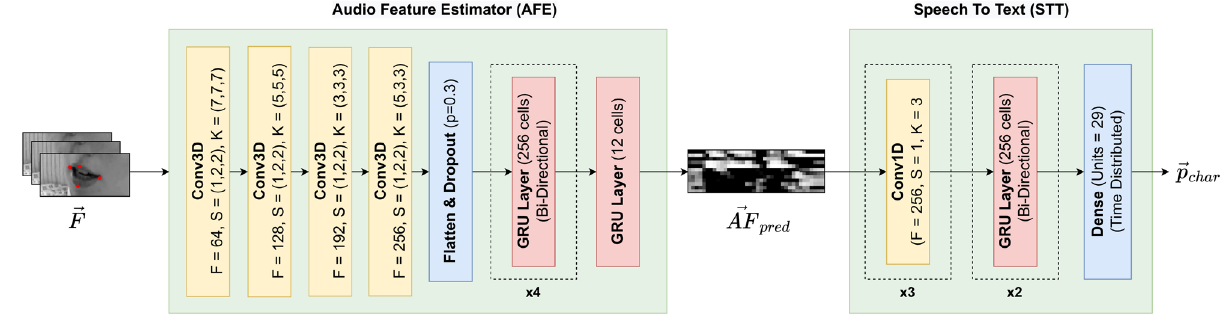
Figure 3. Detailed neural network architecture of AFE and STT. Important hyperparameters are provided in the layer blocks directly, where in the case of convolutional layers, F indicates the number of filters, S the stride and K the kernel size. All convolutional layers are followed by a ReLU-activation function omitted in the figure for readability. Identical, subsequent layers are indicated by a dashed box with the number of repetitions given